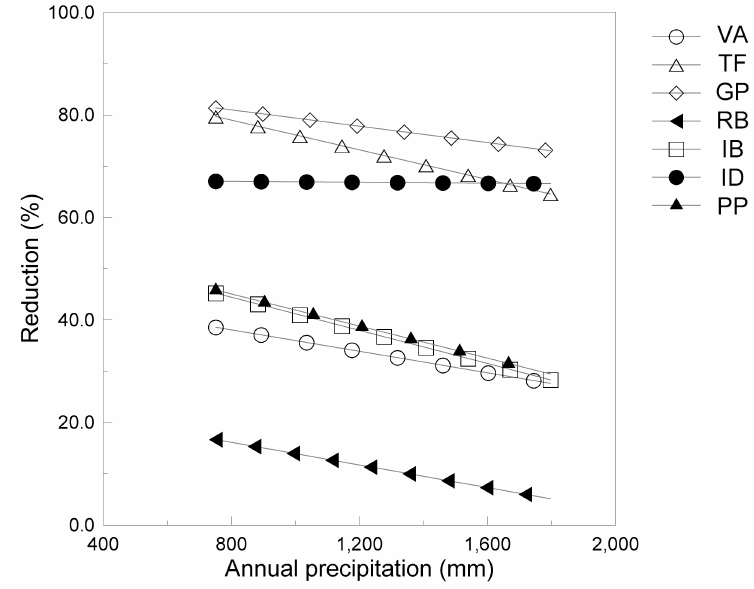
Figure 8. Runoff reduction trend by annual precipitation for all LID